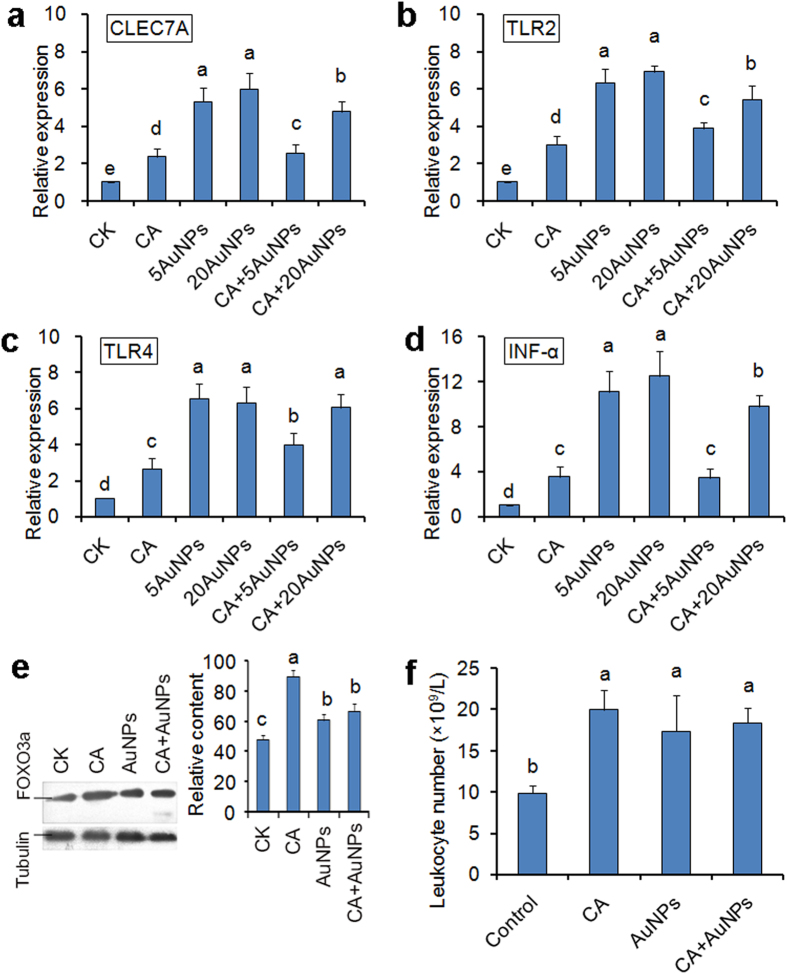
Activation of immune response in DPSCs and mice by C. albicans and AuNPs.(a–d) Expression levels of immune response-related genes in DPSCs under treatment of C. albicans (CA), 5 ppm AuNPs (5AuNPs), 20 ppm AuNPs (20AuNPs), C. albicans in combination with 5 ppm AuNPs (CA + 5AuNPs) or C. albicans in combination with 20 ppm AuNPs (CA + 20AuNPs). (e) Protein levels of FOXO3a in DPSCs. FOXO3a was detected by anti- FOXO3a mono-antibody, and tubulin was used as the normalized protein. Columns on the right indicate the statistical results of FOXO3a contents. (f) Leukocyte numbers in the blood of mice after treated by C. albicans, AuNPs alone or in combination. 1 mL of C. albicans cell suspension (1 × 106 cells/mL), 1 mL of AuNP solution (5 ppm) or 1 mL of the mixture containing C. albicans cells (1 × 106 cells/mL) and AuNP (5 ppm) was intraperitoneally administered to healthy mice. The blood of the mice was then sampled to determine the number of leukocytes. The error bars indicate one standard deviations (n = 3). Identical letters indicate no statistical differences among treatments (P < 0.05).